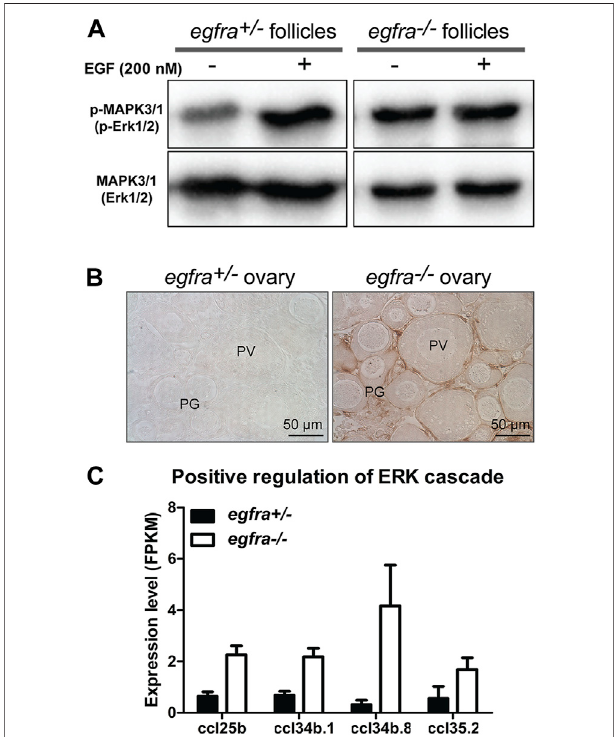
FIGURE 7 | Loss of MAPK signaling response to EGF in egfra mutant ovary. (A) EGF treatment of ovarian fragments in vitro induced phosphorylation of MAPK3/1 (Erk1/2) in egfra +/ − but not egfra − / − follicles. However, the mutant ovary showed higher basal level of MAPK phosphorylation despite its lack of response to EGF. (B) Immunohistochemical staining for MAPK3/1 phosphorylation in the control and mutant ovaries without EGF treatment. High level of phosphorylated MAPK3/1 was located in the somatic follicle cells of the egfra − / − ovary. (C) Increased expression of chemokine ligands ( ccl25b , ccl34b.1 , ccl34b.8 , and ccl35.2 ) in egfra − / −